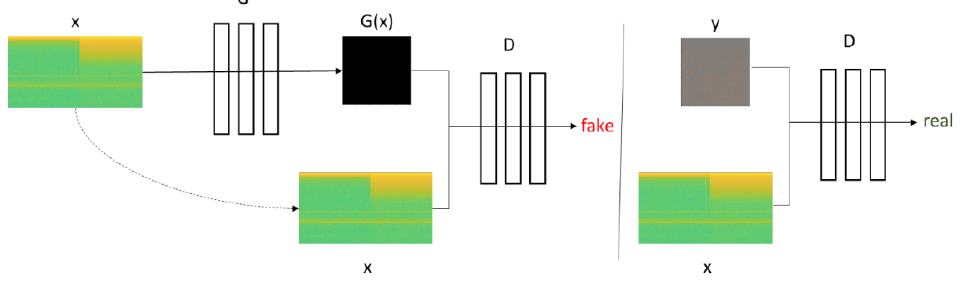
Figure 4. Training of conditional Generative Adversarial Network (GAN).